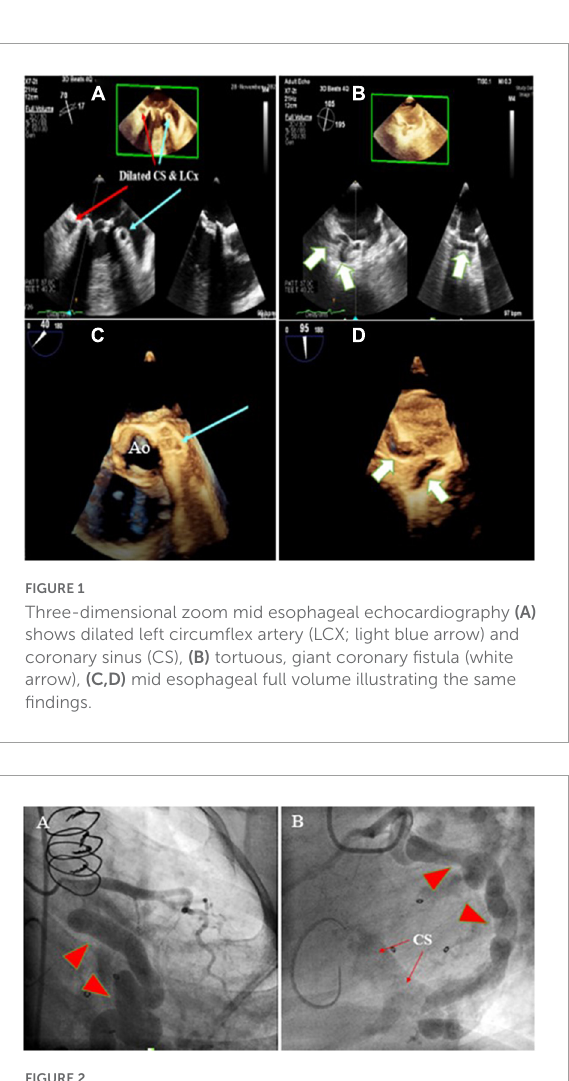
FIGURE2 Coronary artery cineangiography in 30 ◦ RAO (left; A ) and 60 ◦ LAO (right; B ) projections show a giant coronary artery (red isosceles triangles) starting from the proximal left circumflex artery and terminating in the same artery (narrow arrows).